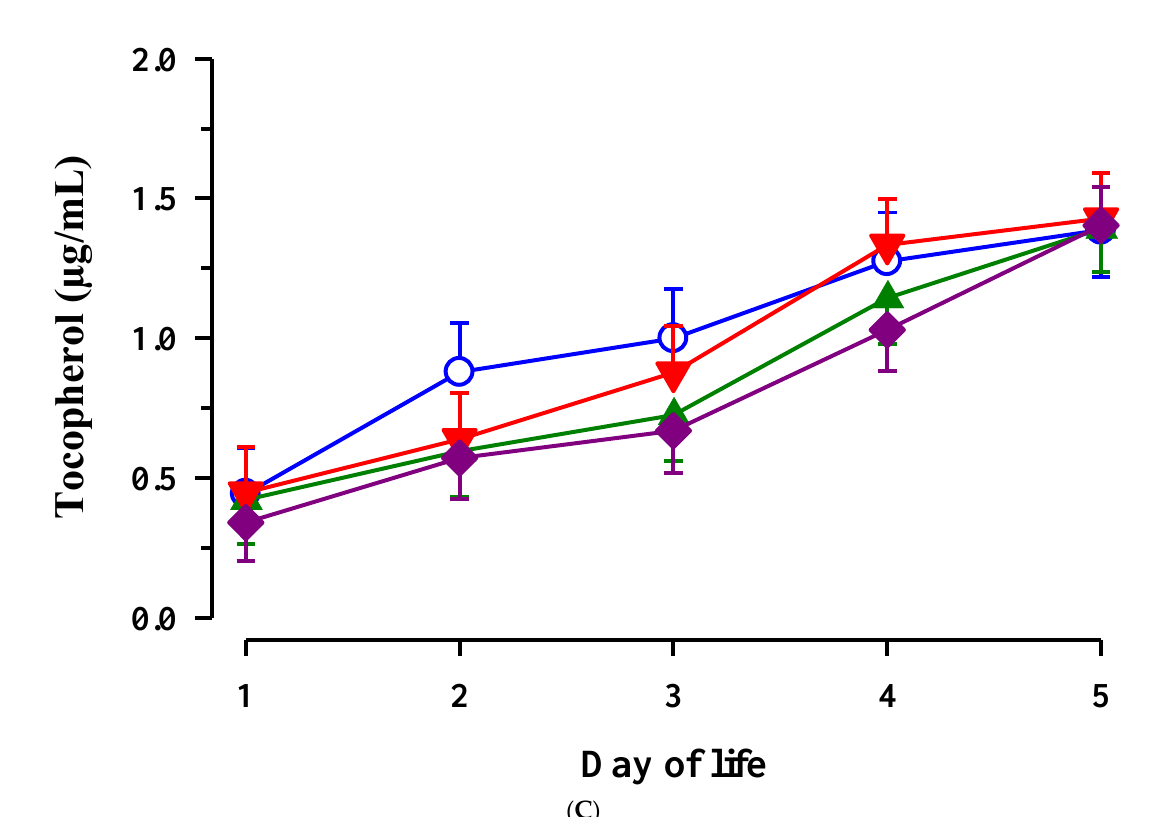
Figure 5. Plasma β - carotene ( A ), retinol ( B ), and tocopherol ( C ) concentrations in calves dependent on maternal fatty acid supplementation ( ○ control, CON n = 9; ▲ EFA, essential fatty acid, n = 9; ▼ , CLA, conjugated linoleic acid, n = 9; ♦ , EFA + CLA, n = 11) and time after birth. Day 1 corresponded to the day of birth. X marks differences between calves with maternal EFA supplementation and without maternal EFA supplementation within the time points ( p < 0.05).